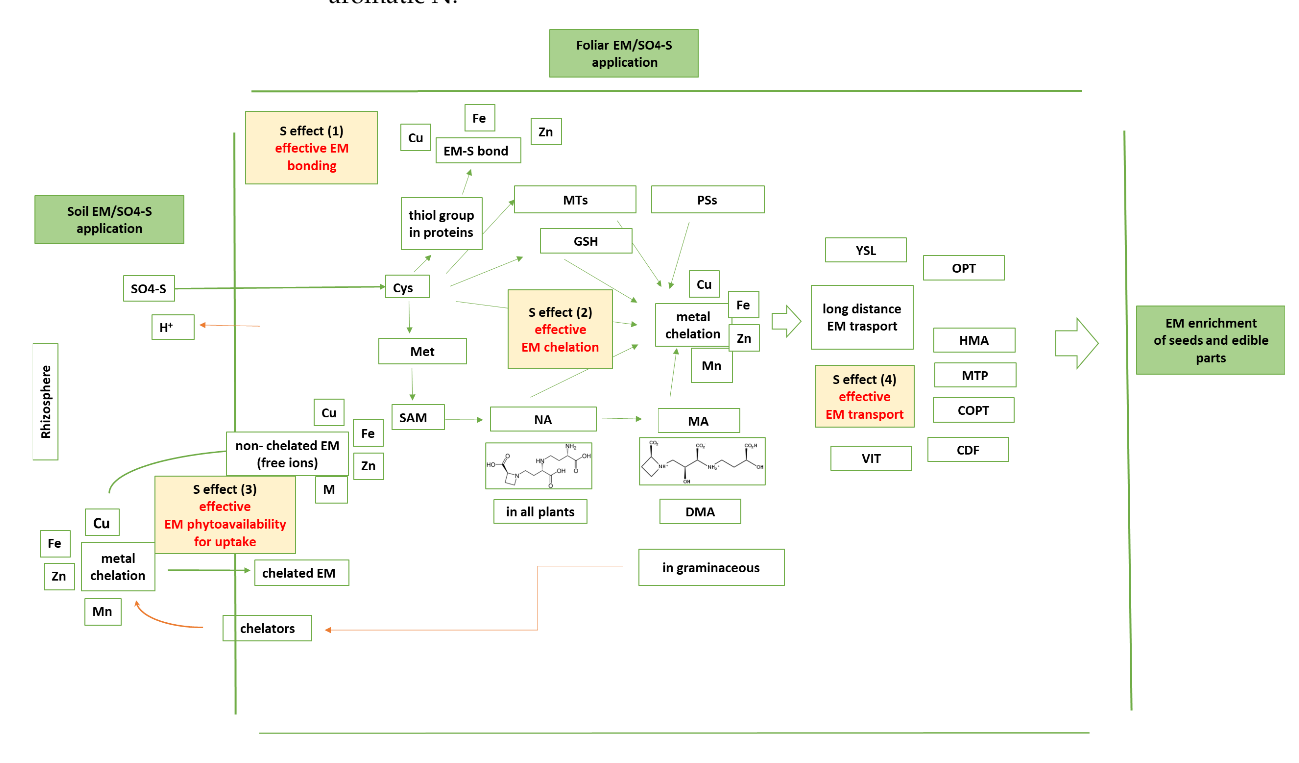
Figure 1. The contribution of S homeostasis in essential micronutrients’ homeostasis within plants toward efficient seed EM loading.